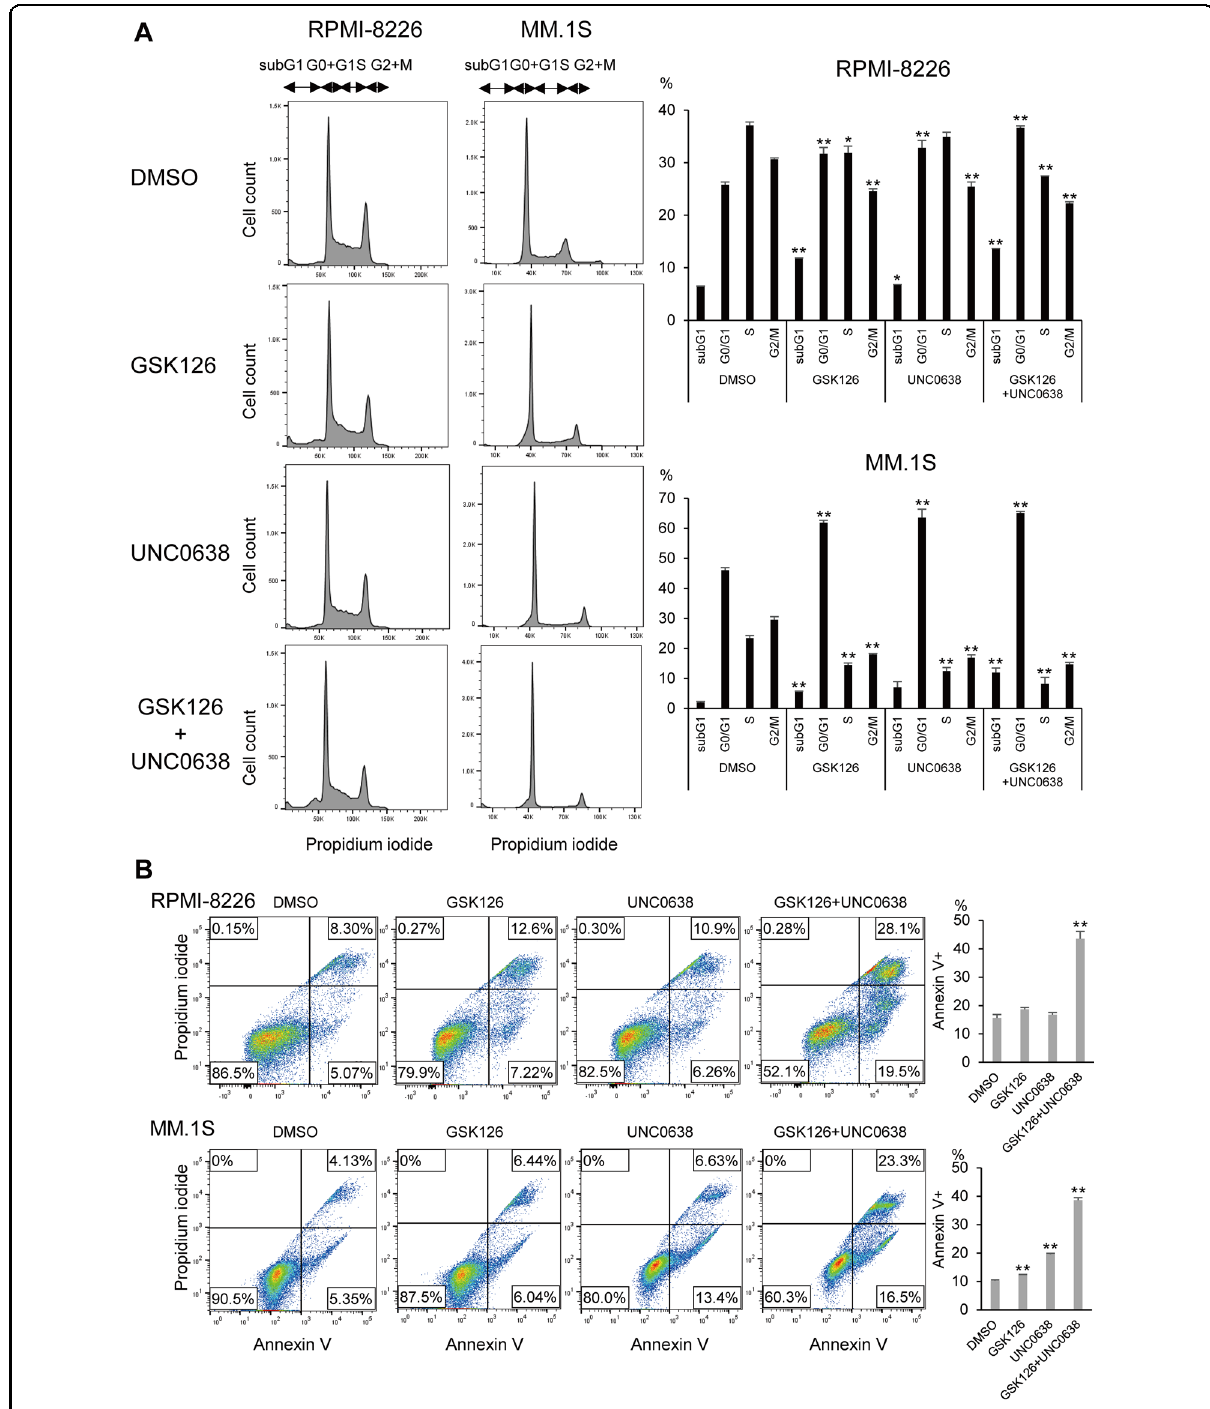
Fig. 2 Effects of EZH2 and G9a inhibitors on the cell cycle and apoptosis in MM cells. A Cell cycle analysis in MM cell lines treated with the indicated drugs (1 μ M, 6 days). Representative data are shown on the left. Summarized data from three biological replications are shown on the right; error bars represent SEMs. B Apoptosis assays in MM cells treated with the indicated drugs (1 μ M, 6 days). Representative data are shown on the left. Summarized data from three biological replications are shown on the right; error bars represent SEMs. * P < 0.05, ** P <